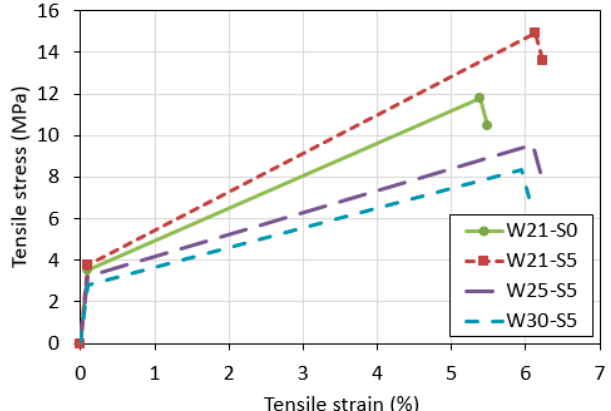
Figure 5. Comparison of tensile stress and strain curves of all mixtures.